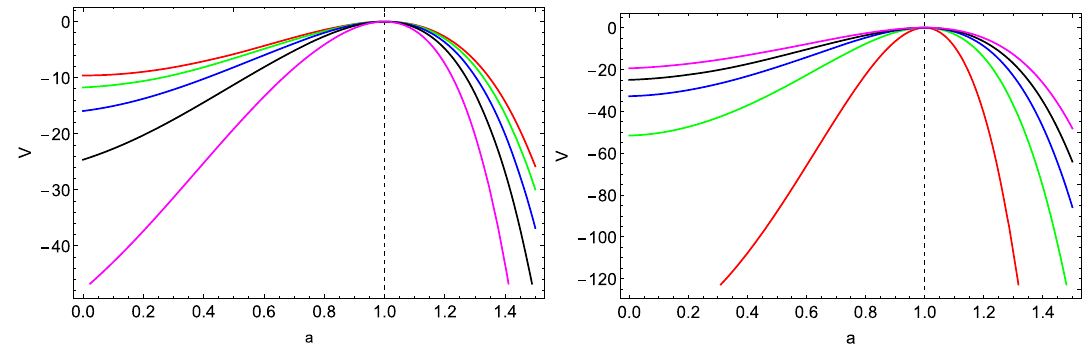
Fig. 1 Effective potential plotted as function of a for a ∗ = 1, L = 1, k = 1: left fixed λ = 0 . 015 and γ i = 0, 2.5, 5, 7.5, 10 (red, green, blue, black, magenta), right fixed γ i = 5 and λ = 0.001, 0.003, 0.005, 0.007, 0.01 (red, green, blue, black, magenta), where i = { a , b , c }